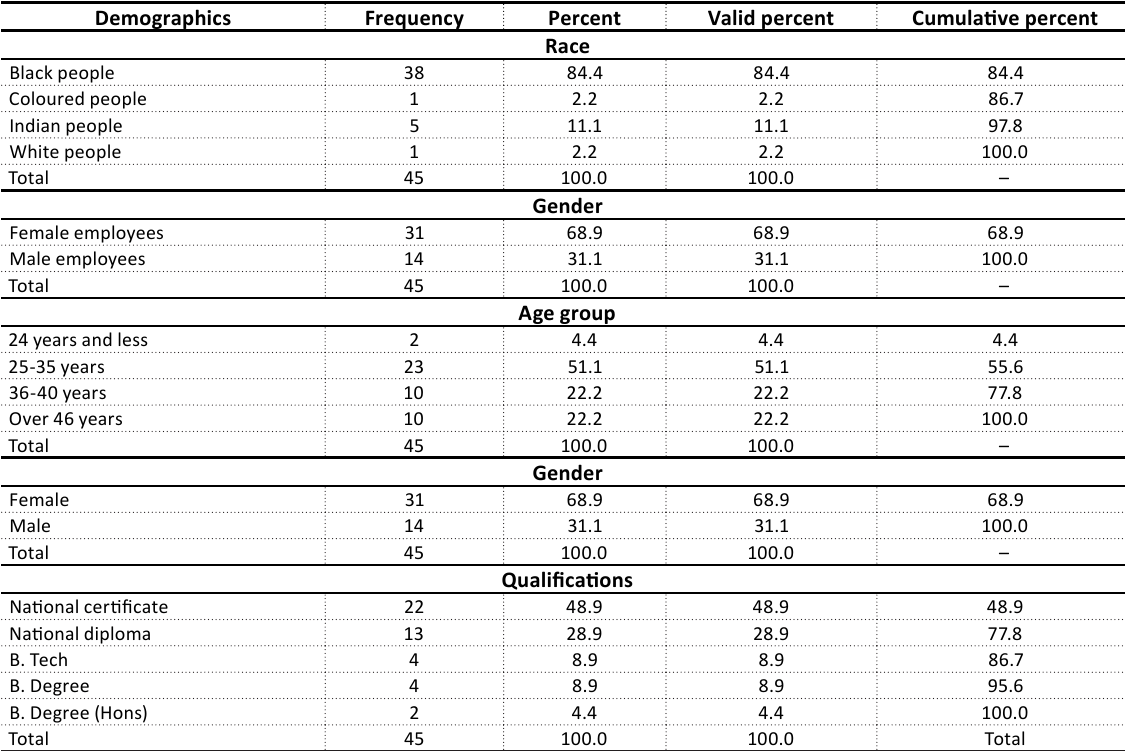
Table 1. Frequency showing the demographics based on race, gender and age group Demographics Frequency Percent Valid percent Cumulative percent Race Black people